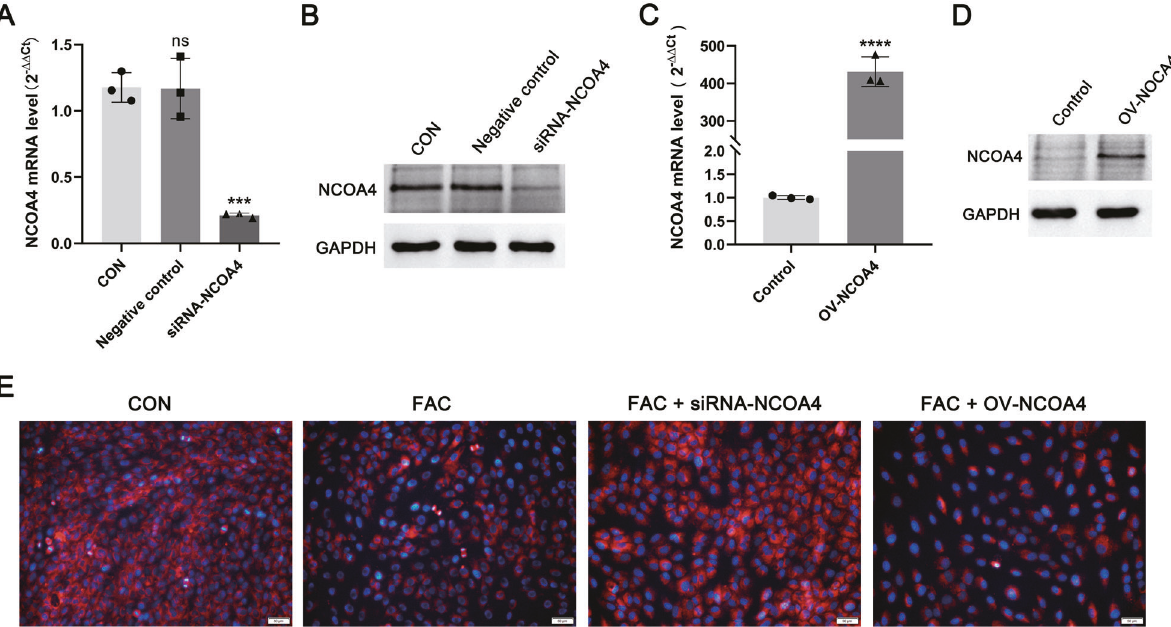
Fig. 3 NCOA4-overexpressing and-silent. A , B Western blot analysis of KGN after siRNA silencing of NCOA4 (siRNA-NCOA4), control group, and negative control group. Expression of GAPDH protein was used as an internal control. C , D Western blot analysis of NCOA4- overexpression KGN (OV-NCOA4) and control groups. Expression of GAPDH protein was used as an internal control. E Representative images of lipid peroxidation and iron staining in KGN cells with silenced or overexpressed NCOA4. Blue represents iron, and red represents reduced state lipid peroxides. Scale bar = 50 µm. Data are expressed as means ± SD and analyzed by Student ’ s t test or one-way ANOVA. *** P < 0.001, **** P < 0.0001 and ns, no signi fi